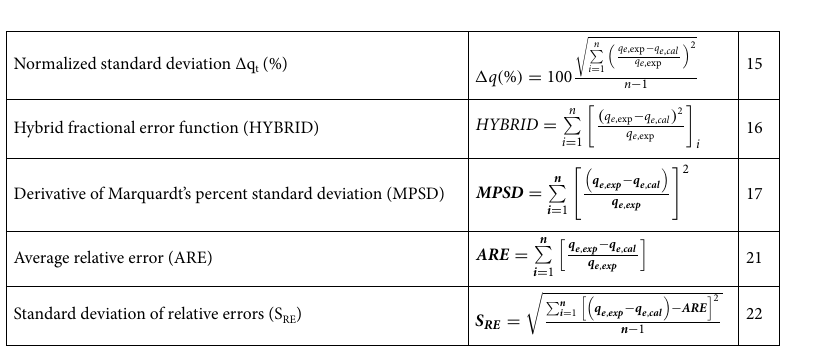
Standard deviation of relative errors (S RE Table 6. Adsorption statistical error validity models (ASEVM) 24,43,44,46 .